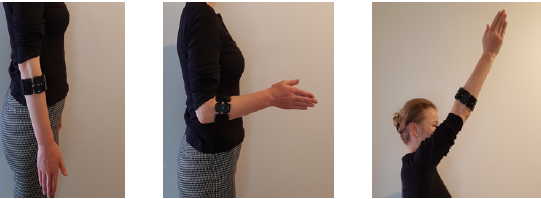
Figure 6. Active hand motions included in the experimental evaluation. From left to right: oh , ch , wp , ws and pg .